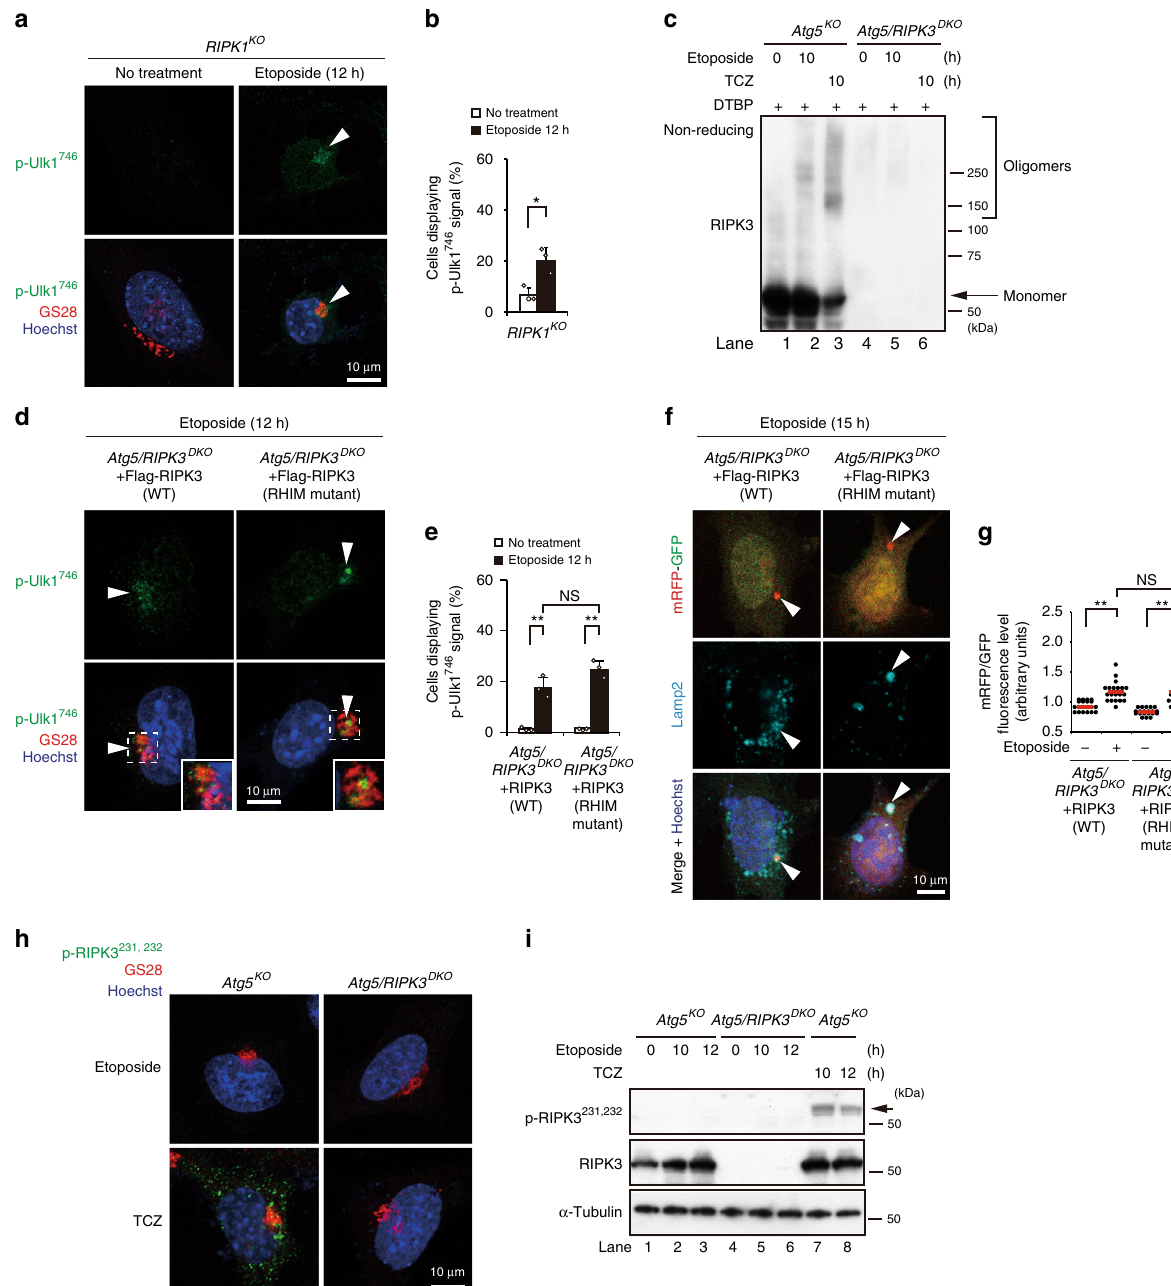
Fig. 6 Different mechanisms of RIPK3 activation by etoposide and TCZ treatment. a , b RIPK1 is not involved in alternative autophagy. RIPK1 KO cells were treated with or without etoposide (10 µ M) for 12h, and immunostained with anti-p-Ulk1 746 and anti-GS28 antibodies. Arrowheads indicate p-Ulk1 746 signals. b The population of cells displaying p-Ulk1 746 signals was calculated ( n ≥ 100 cells). p = 0.025. c Lack of RIPK3 oligomerization by etoposide treatment. The indicated MEFs were treated with or without etoposide or TCZ for 10h. Cells were then incubated with 2mM DTBP for 30min. Nonreduced lysates were subjected to western blotting. Note the increase in oligomer bands and the decrease in the monomer band only by TCZ treatment. d – g No requirement of the RHIM domain in etoposide-induced alternative autophagy. Similar experiments to Figs. 1d and 2b were performed using Flag-RIPK3 (WT)-transfected Atg5/RIPK3 DKO MEFs and Flag-RIPK3 (RHIM mutant)-transfected Atg5/RIPK3 DKO MEFs. Representative images are shown in d . Magni fi ed images are shown in the insets. Arrowheads indicate p-Ulk1 746 signals. In e , the population of cells displaying p-Ulk1 746 signals was calculated ( n ≥ 100 cells). Atg5/RIPK3 DKO + RIPK3 (WT): no treatment vs. etoposide: p = 0.0004, Atg5/RIPK3 DKO + RIPK3 (WT) vs. Atg5/RIPK3 DKO + RIPK3 (RHIM mutant): etoposide: p = 0.0545. Representative images are shown in f . Arrowheads indicate mRFP – GFP red puncta. In g , the extent of red puncta was indicated by the RFP/GFP ratio per cell ( n = 20 cells). Red lines indicate the mean value. Atg5/RIPK3 DKO + RIPK3 (WT) vs. Atg5/RIPK3 DKO + RIPK3 (RHIM mutant) etoposide: p = 0.997. h , i p-RIPK3 231,232 is not induced in etoposide-induced alternative autophagy. The indicated MEFs were treated with etoposide (10 µ M) or TCZ for 10h. In h , cells were immunostained with anti-p-RIPK3 231,232 and anti-GS28 antibodies. In i , the expression of each protein was analyzed by western blotting. The p-RIPK3 231,232 signal (arrow) was observed in TCZ-treated MEFs, but not etoposide-treated MEFs. In b and e , data are shown as the mean±SD ( n = 3). Comparisons were performed using unpaired two-tailed Student t -tests in b or using one-way ANOVA followed by the Tukey post-hoc test e and g . * p <0.05; ** p <0.01; NS: not signi fi cant. Source data are provided as a Source Data fi